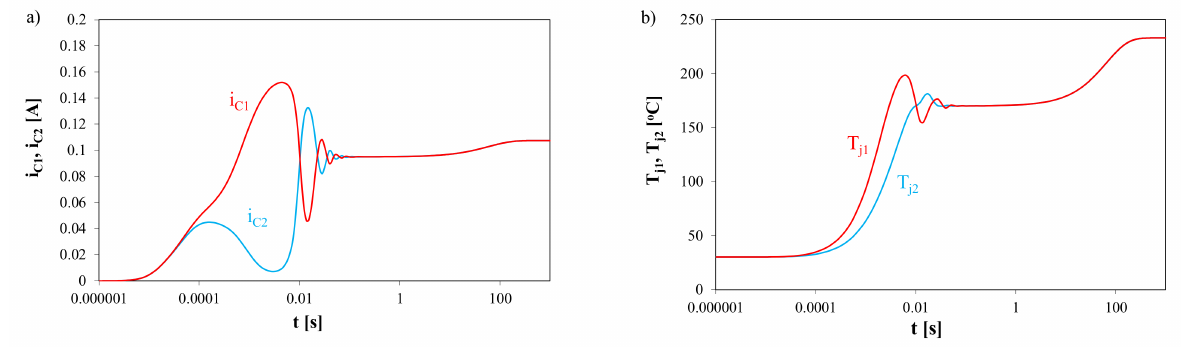
Figure 15. Collector currents ( a ) and junction temperatures ( b ) of BJTs with the same values of thermal resistances R th 1 = R th 2 = 250 K/W, different values of the shortest thermal time constants and with transfer the thermal resistance R th 12 = 240